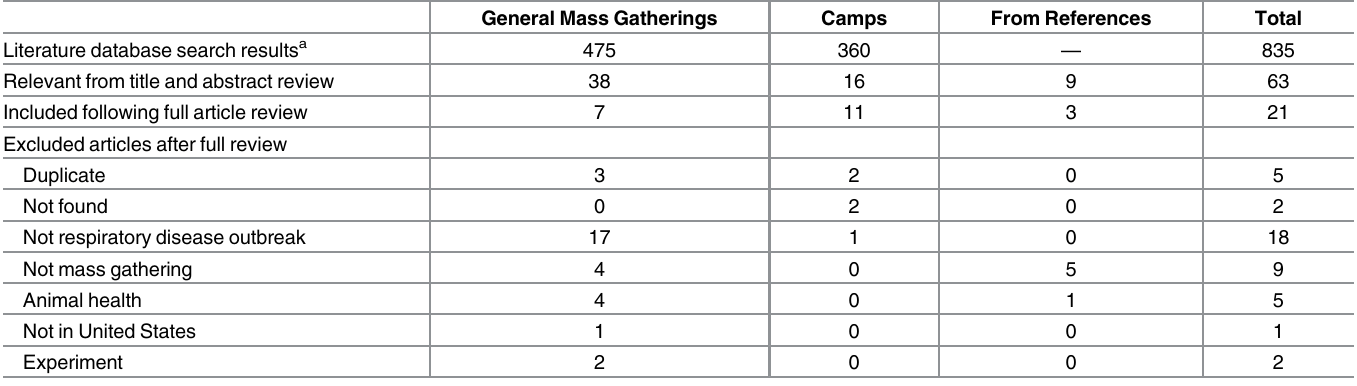
Table 1. Categorization of the published literature reviewed for identifying mass gathering-related respiratory disease outbreaks in the United States, January 1, 2005 – December 31,